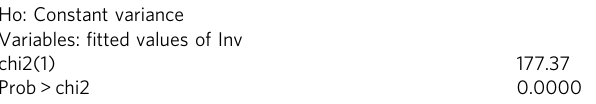
**Correlation is signi fi cant at the 0.01 level (two-tailed).